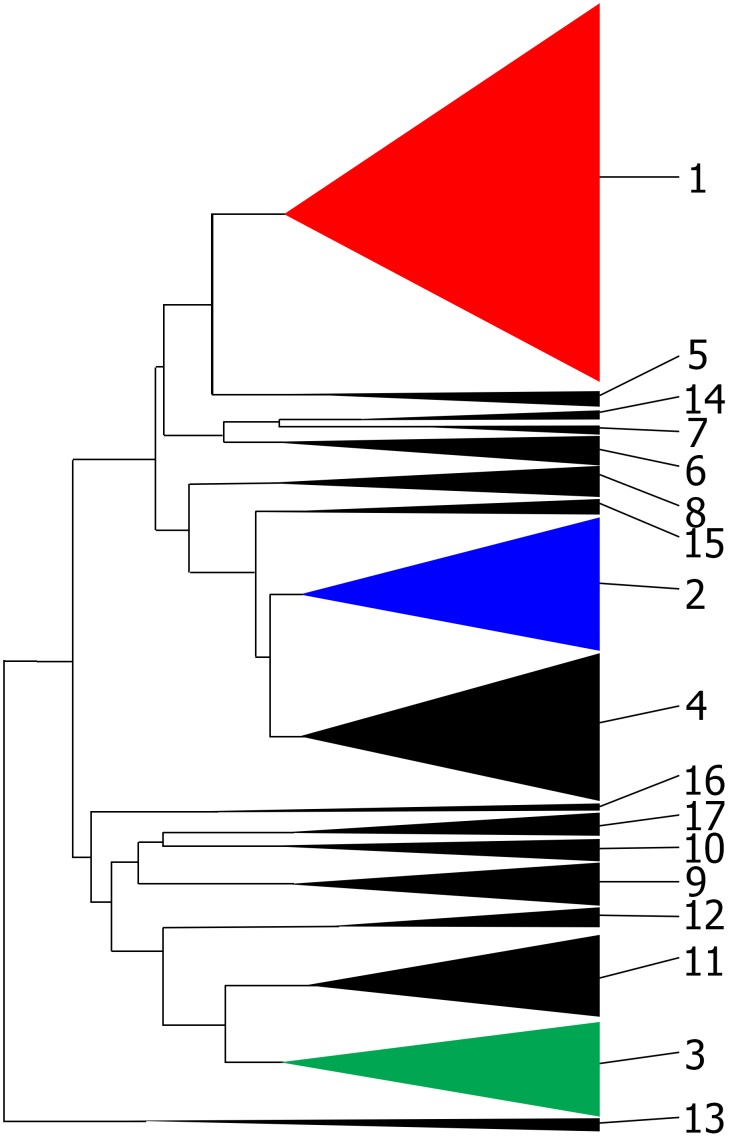
MLST clade architecture proposed by [28] for Candida albicans.Singleton STs are excluded and only the clades are shown. MLST clade 1 (red), MLST clade 2 (blue) and MLST clade 3 (green) were analyzed in the present work.